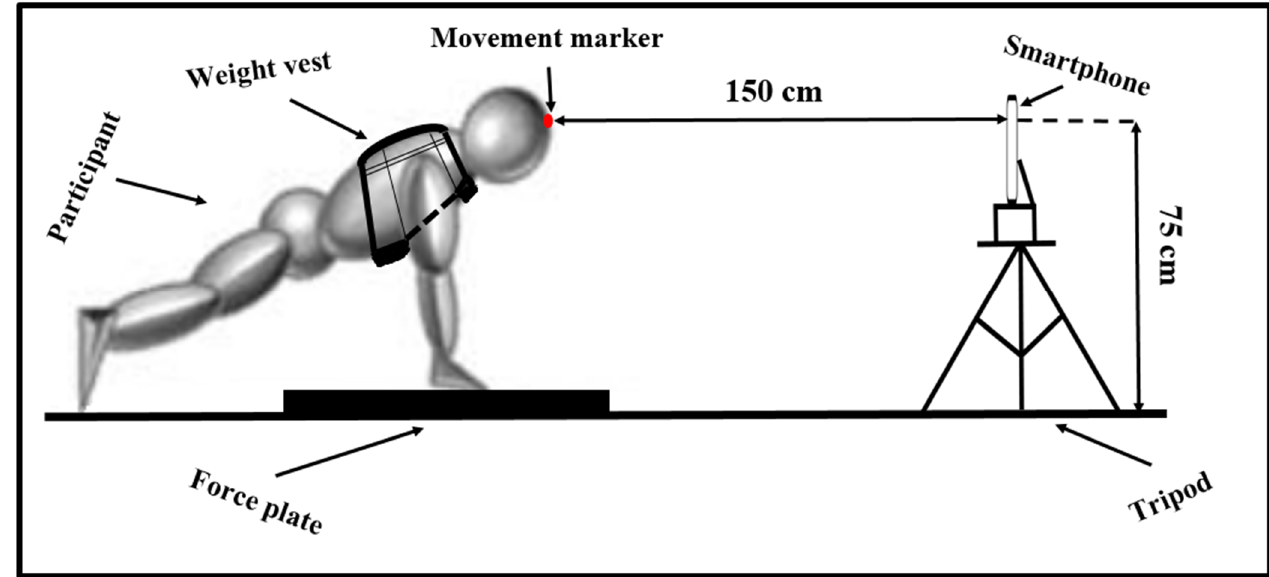
Figure 1. Push-up test condition performed by the participant and the setting up of test equipment. A smartphone (Redmi Note 8, Xiaomi, Beijing, China) with a high-speed camera (Snapdragon 886 processor at 2.0 GHz and 48 + 8 + 2-megapixel quad-cameras) was used to film the push-up exercises. All videos were recorded in the slow-motion option at 240 fps in automatic mode. The smartphone was attached to a tripod 150 cm from the focal plane to the plane of the movement marker placed on the participant’s head. In addition, the main lens of the camera was placed at a 75 cm height [9]. The video recordings of the push-ups were processed with Kinovea software, version 0.8.15 (Joan Charmant & Con- trib., kinovea.org, accessed on 25 October 2021) [10] with a frequency of 240 Hz to ensure the correct calculation of the execution speed [11–13]. A point marker was put on the head of each swimmer. In addition, the displacement of the point maker during the descending and ascending phases of the push-up was limited by two imaginary lines added to the 2D plane in the Kinovea software. The mean concentric velocity was calculated from the dis- tance between the lowest position and the highest position according to the imaginary digital lines, and time it took to cover this distance. The load–velocity relationship was established for the push-up exercise by the aver- age velocity of the three repetitions of the four different loads performed by each partici- pant, as determined by the Kinovea software. Based on the athlete’s performance at dif- ferent loads, linear regression was used to predict the 1RM push-up for each participant. To calculate the predicted 1RM push-up, the following formula was used: y = a × x + b (1) The variable x was set at 0.18 m/s, which indicated the minimum mean propulsive velocity at which 1RM was theoretically achievable [14]. Additionally, the coefficient of x (a) and y-intercept (b) were individualized for each participant. To establish a and b in the linear equation for each participant, scatter plots were produced, and a linear regression line was added using Microsoft Excel (version 18.12, Microsoft, Redmond, Washington, USA). 2.3.2. Swimming Performances Tests After a standard 800 m warm-up (600 m aerobic swim + 200 m progressive sprint), the 25 and 50 m front crawl tests were performed with a diving start. Five minutes of rest were integrated between the two tests. Thirty minutes after the 50 m front crawl test, the 25 and 50 m front crawl tests with arms only were performed with a water start. A pull